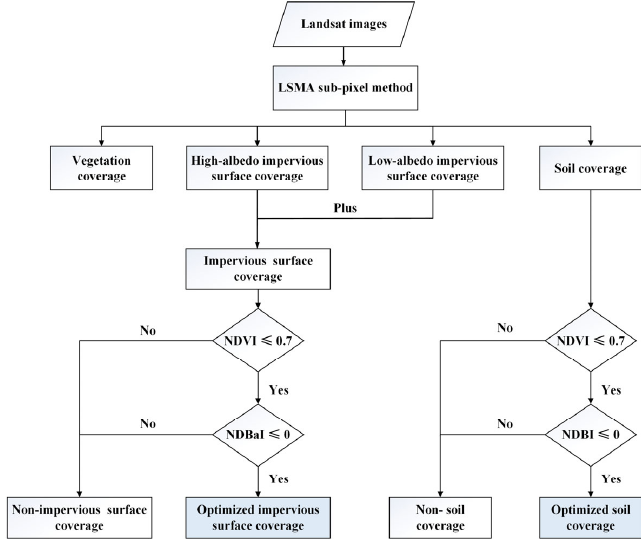
Figure 2. The processing steps for calculation of the impervious surface coverage and the soil coverage. LSMA: linear spectral mixture analysis; NDVI: normalized difference vegetation index; NDBI: normalized different build ‐ up index; and NDBaI: normalized different bare soil index.